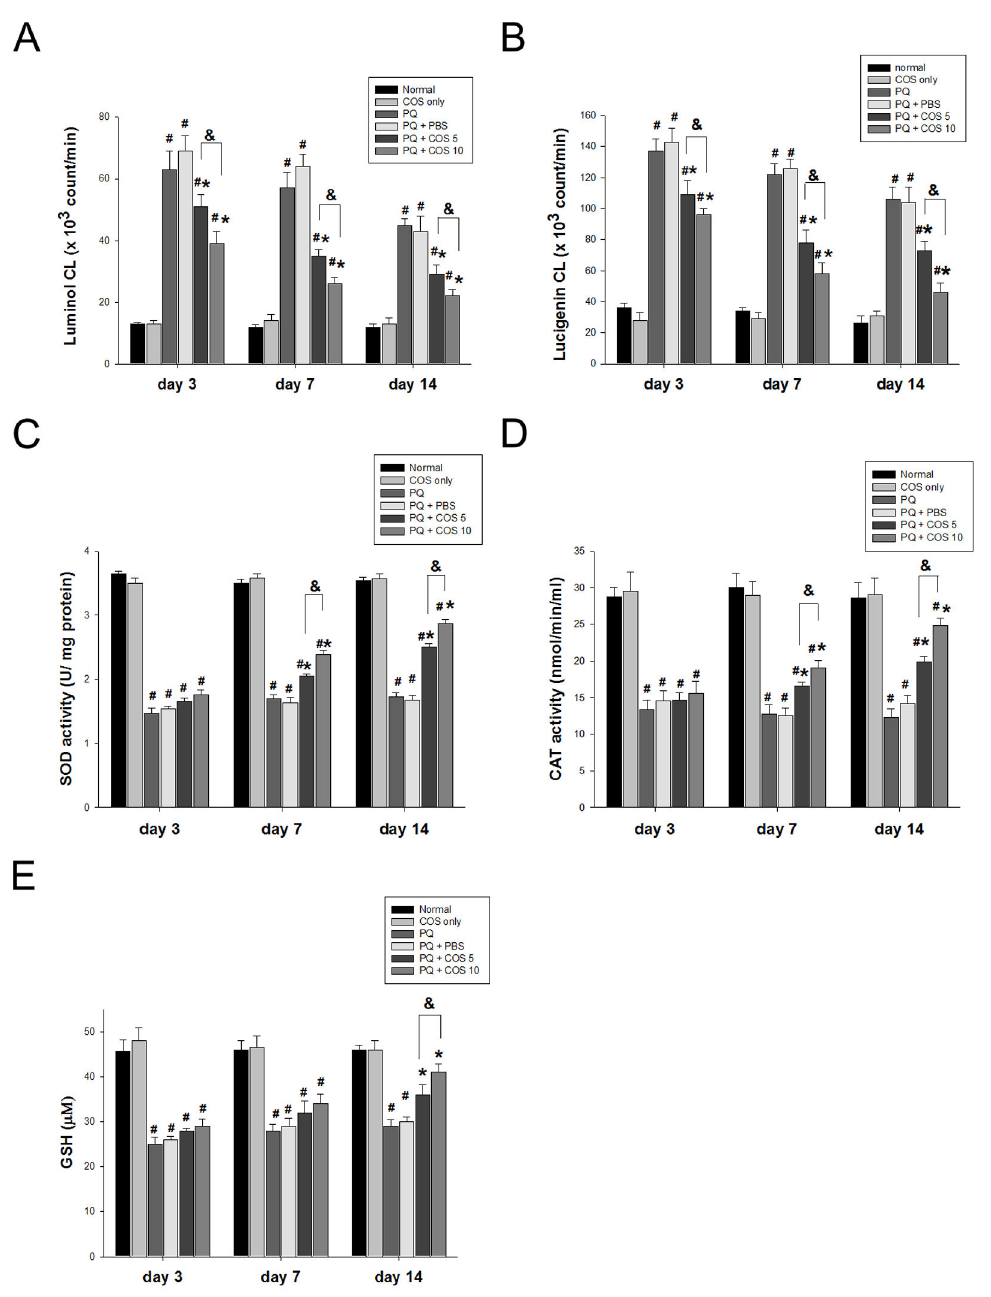
Figure 4. Effects of COS on the amounts of free radicals, antioxidant enzyme activity and glutathione levels. The amounts of free radicals in retina were assessed by using (A) luminol- and (B) lucigenin- dependent chemiluminenscences. The activities of anti-oxidative enzyme: (C) superoxide dismutase (SOD) and (D) catalase and (E) glutathione (GSH) levels in retinas at indicated time points were evaluated by using ELISA. (* P < 0.05 compared with PQ only or PBS-treated group; # P < 0.05 compared with normal; & P < 0.05 by two-way ANOVA with post hoc Bonferroni test; N=3 for each group in each time point). doi: 10.1371/journal.pone.0077323.g004 treated group; one-way ANOVA with post hoc Bonferroni test; Next, we examined the effect of COS on the anti-oxidative N=3 in each group) (Figure 6C). enzyme catalase activity and GSH levels in PQ-stimulated RGC-5 cells. COS, at the concentration of 100 µg/ml, caused a